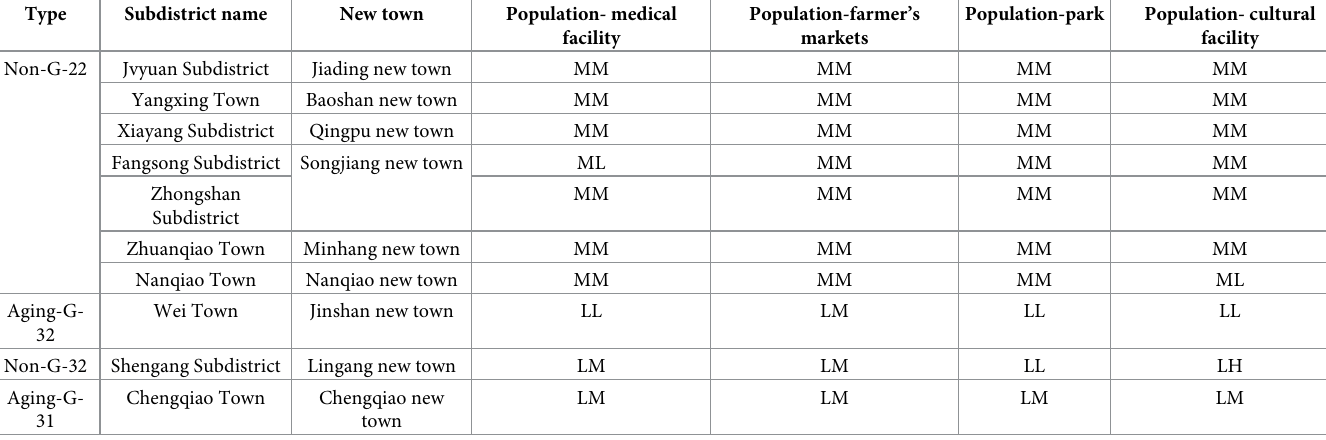
Table 6. The matching value of population density and community accessibility to facilities in planned new towns.